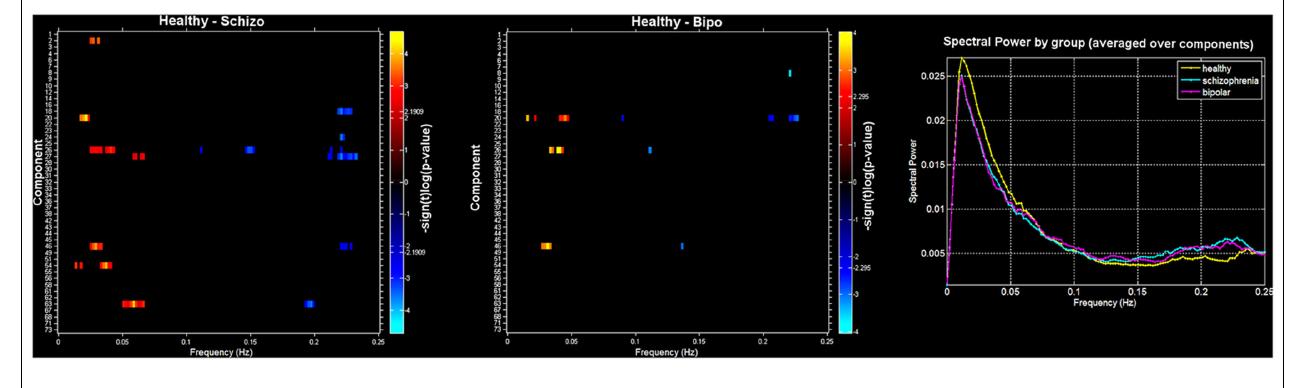
Color maps in left and middle panels show the power differences at each frequency over each component separately. Rightmost panel shows the mean power spectra for each group, averaged over all components.